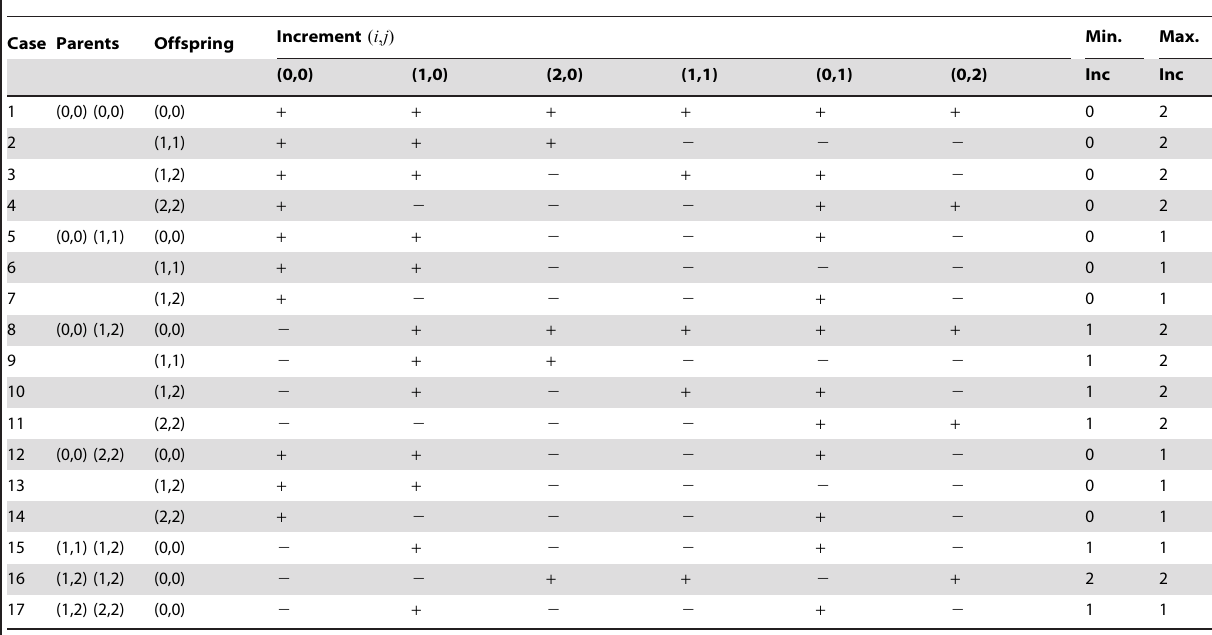
Table 6. Admissible increments of u and v .